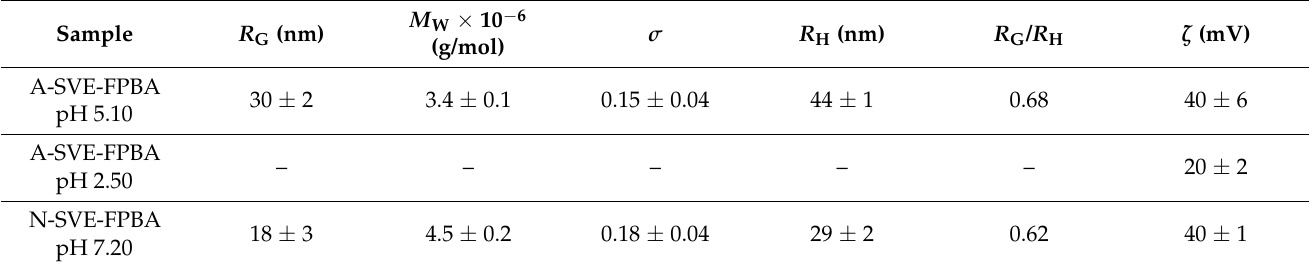
Table 1. Light scattering data (mean ± s.d. of three measurements). R G =radius of gyration, M W = weight-averaged molecular mass, R H = hydrodynamic radius, σ = width of the distribution function of diffusion coefficients and ζ = zeta